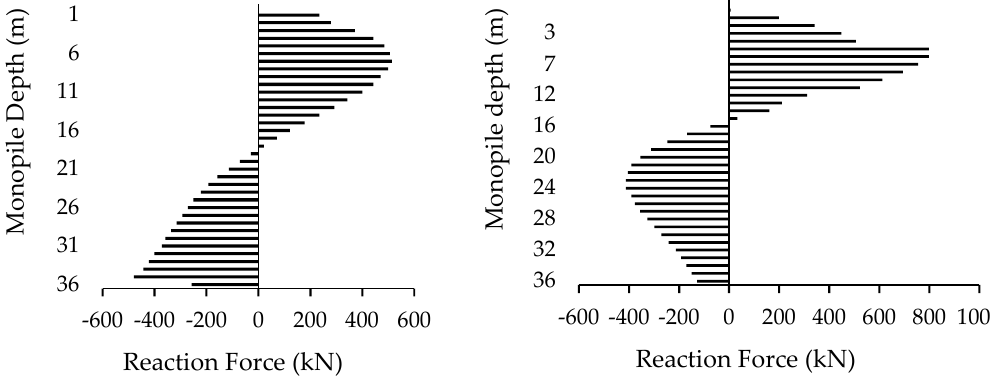
Figure 17. Reaction forces registered for: Pt 0 model (left); and OC 0 model (right).